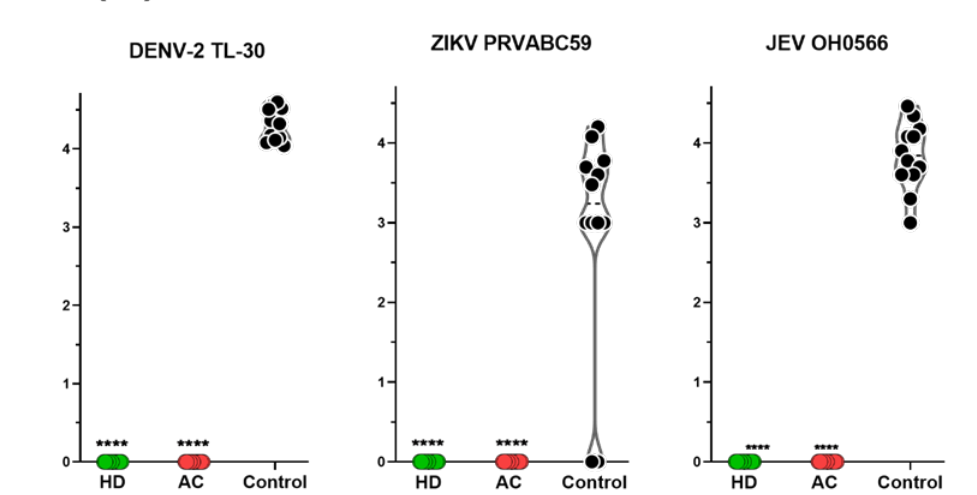
Figure 5. Antiviral activity in human cells. Cells were treated with HD or AC at a concentration of 5 mg/mL. ( A ) K562 cells were infected with JEV OH0566 at MOI 0.01 and ZIKV PRVABC59 and DENV-2 TL-30 at MOI 0.5; ( B ) T98G cells were infected with each virus at MOI 0.5; ( C ) HEK293T cells were infected with JEV OH0566 at MOI of 0.5 and ZIKV PRVABC59 and DENV-2 TL-30 at MOI of 1. Supernatants were collected at 72 h p.i. for JEV OH0566 and ZIKV PRVABC59 and 96 h p.i. for DENV-2 TL-30. Viral titers were determined by plaque assay. The error bars represented the standard deviation of the mean of duodecuplicate (12 copies); ** p < 0.01; *** p < 0.001; **** p < 0.0001. HD: Hedyotis diffusa ; AC: Artemisia capillaris